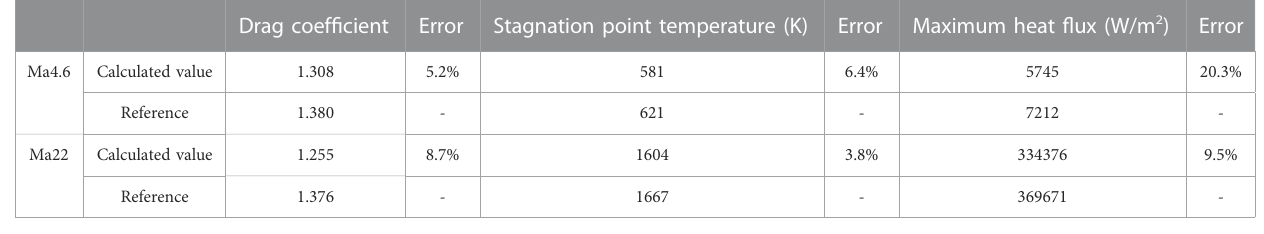
TABLE 3 Flow fi eld analysis veri fi cation results statistics.